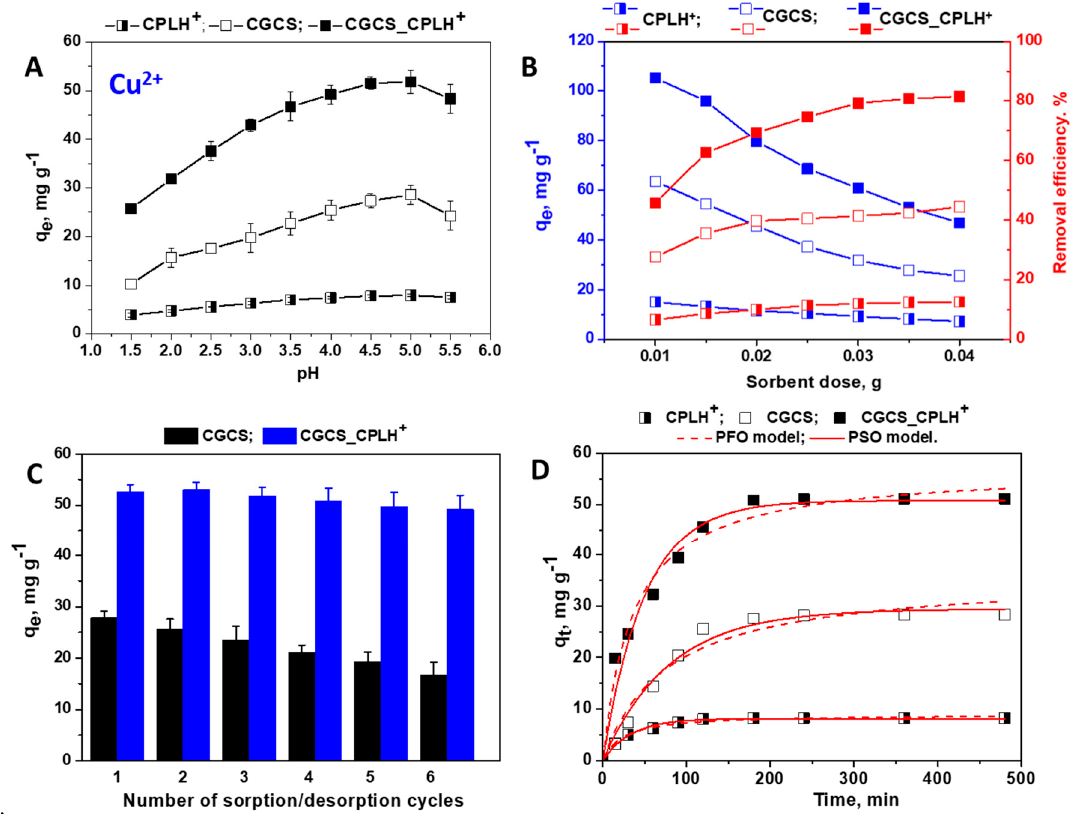
Figure 2. Influence of ( A ) pH values, ( B ) sorbent dose, ( C ) successive sorption / desorption cycles, and ( D ) contact time onto Cu 2 + ions removal from multicomponent mixtures by CPLH + , CGCS, and CGCS_CPLH + sorbents.